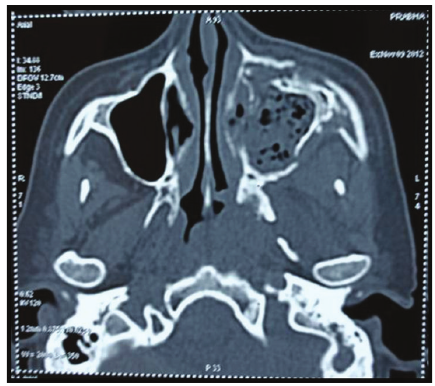
Figure5:AxialviewofCTshowingdestructionofposterior,medial, and anterior walls of left maxillary sinus.